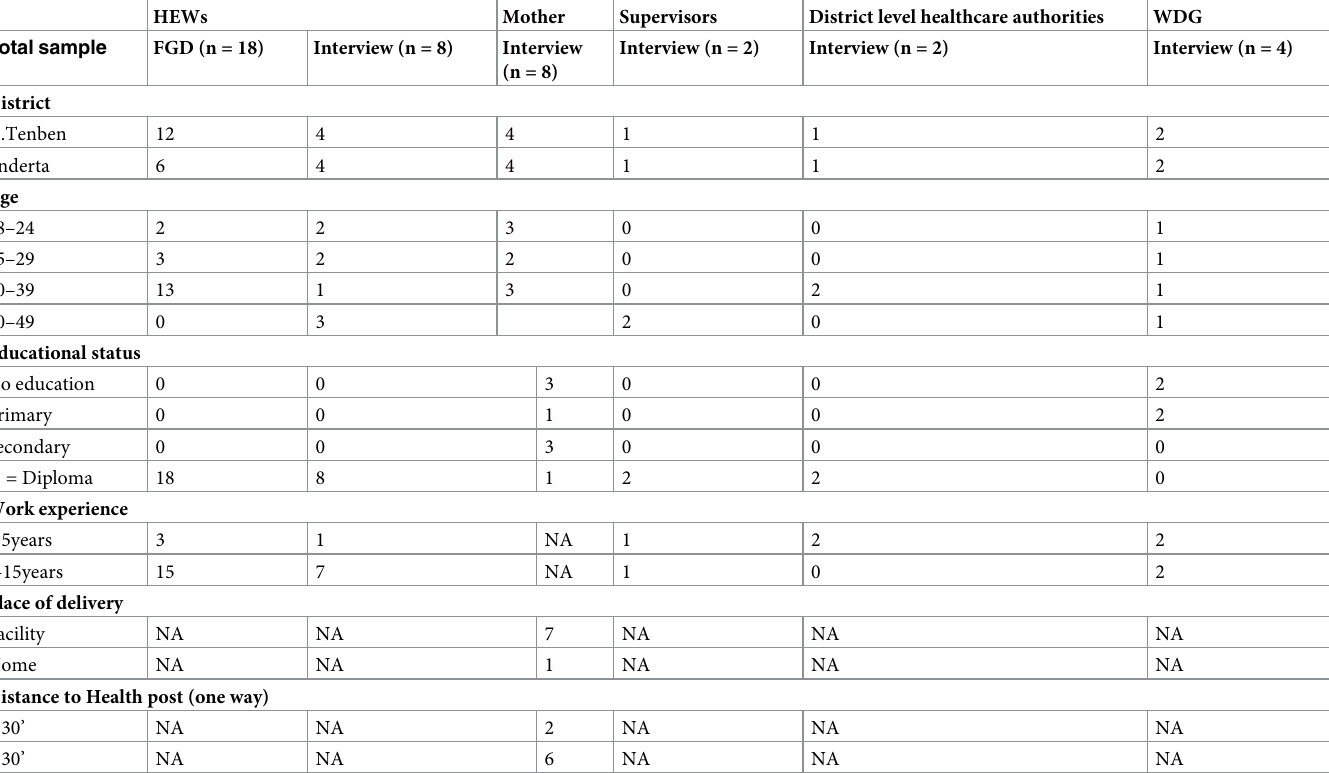
Table 2. Characteristics of the study participants in the rural districts of Northern Ethiopia.